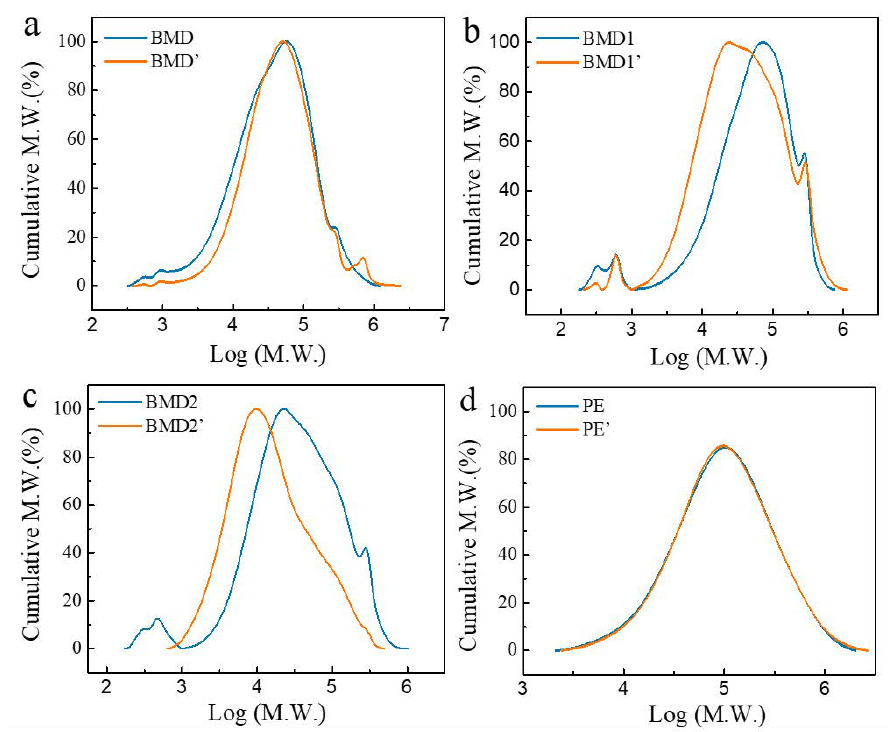
Figure 3. Molecular weight distribution curves of films before (( a ) BDM, ( b ) BDM1, ( c ) BDM2, ( d ) PE) and after mulching (( a ) BDM’, ( b ) BDM1 (cid:48) , ( c ) BDM2 (cid:48) , ( d )